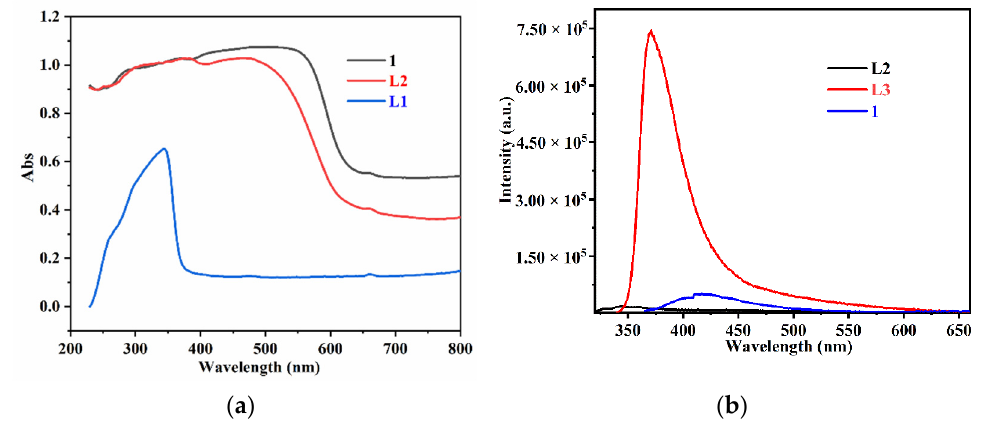
Figure 4. Solid-state UV-Vis absorption; ( a ) emission spectra ( b ) of L1 , L2 , and 1